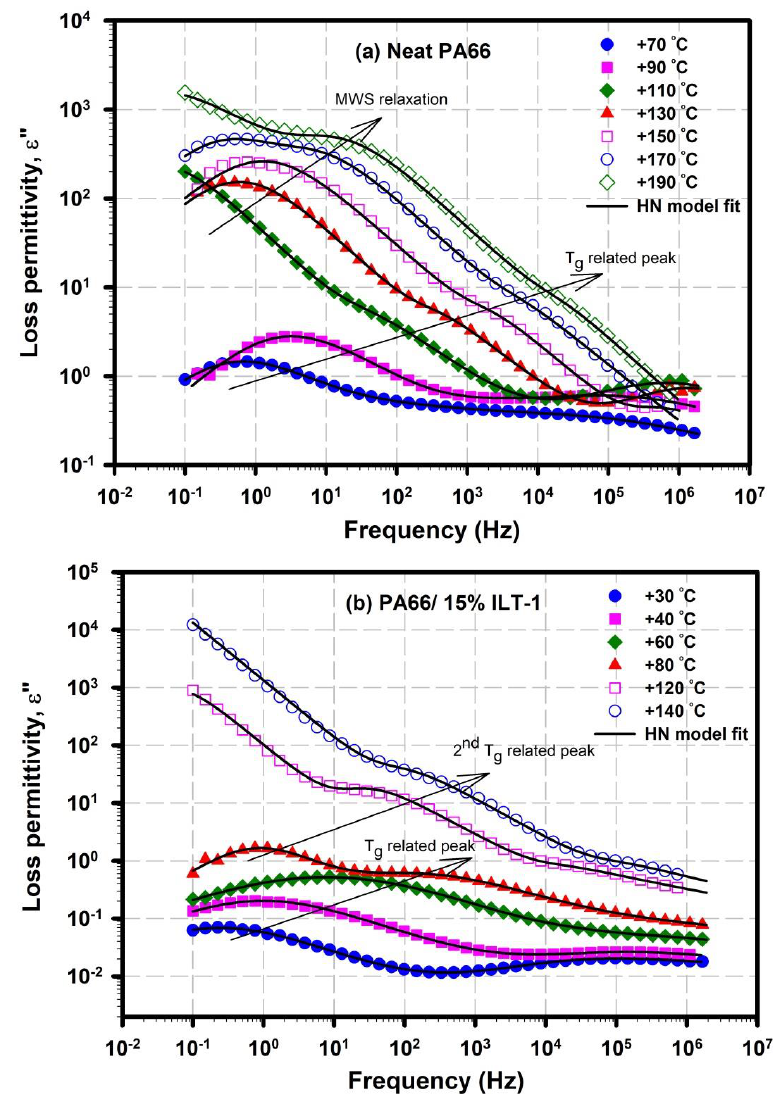
Figure 7. ε ″ vs. f spectra at different temperatures for the studied PA66/ILT-1sample as compared to the processed virgin PA66 showing the α relaxation. Lines show the HN equation fits to the spectra.